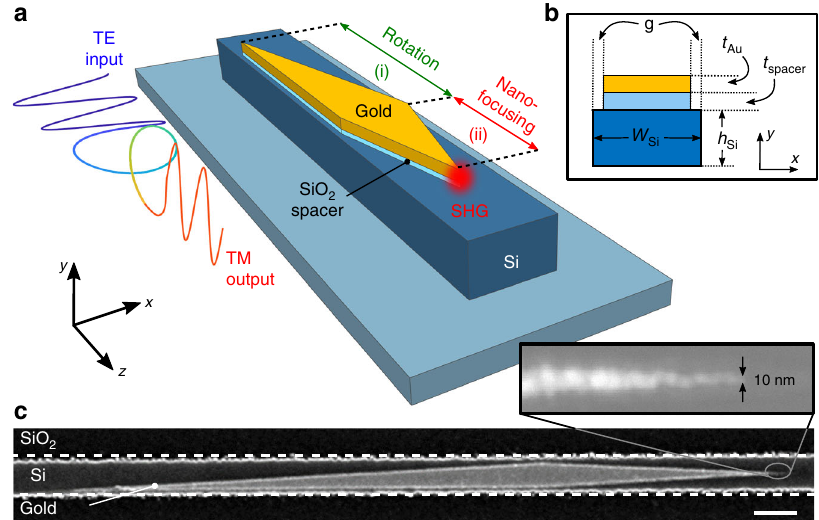
Fig. 1 Schematic and scanning electron micrograph of silicon-on-insulator hybrid plasmonic circuit. a An industry-standard TE ridge waveguide is followed by two in-series plasmonic circuit modules: (i) ef fi cient TE-photonic to TM-plasmonic rotator and (ii) nano-focusing tip. b Geometric parameters at the rotator-focuser boundary. c Scanning electron micrograph (SEM) of a fabricated device. Scale bar: 400 nm. Here, w Si = 350 nm; h Si = 220 nm; g = 25 nm; t spacer = 20 nm; t Au = 50 nm Inset: high-resolution nanotip detail, revealing 10 nm apex